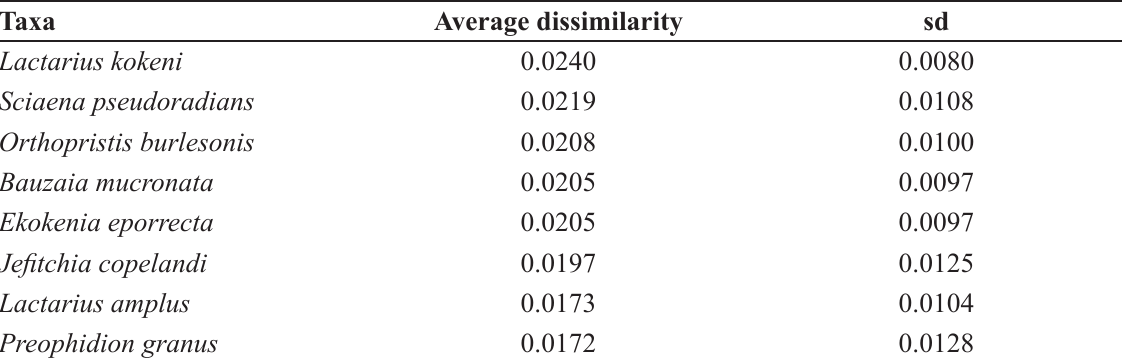
Table S1. Results of the SIMPER analyses between the Claibornian and Jacksonian assemblages. The first eight taxa of contribution to the overall average dissimilarity are listed in decreasing order. sd, standard